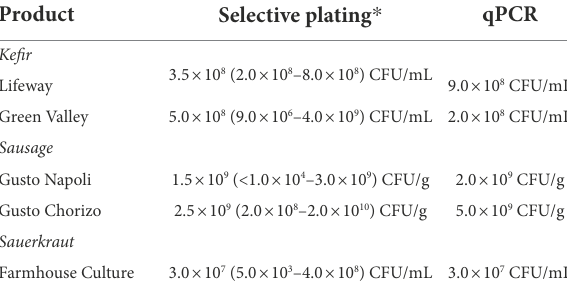
TABLE 1 Lactobacillaceae concentrations in fermented foods determined by selective plating onto MRS and Elliker agar and qPCR.